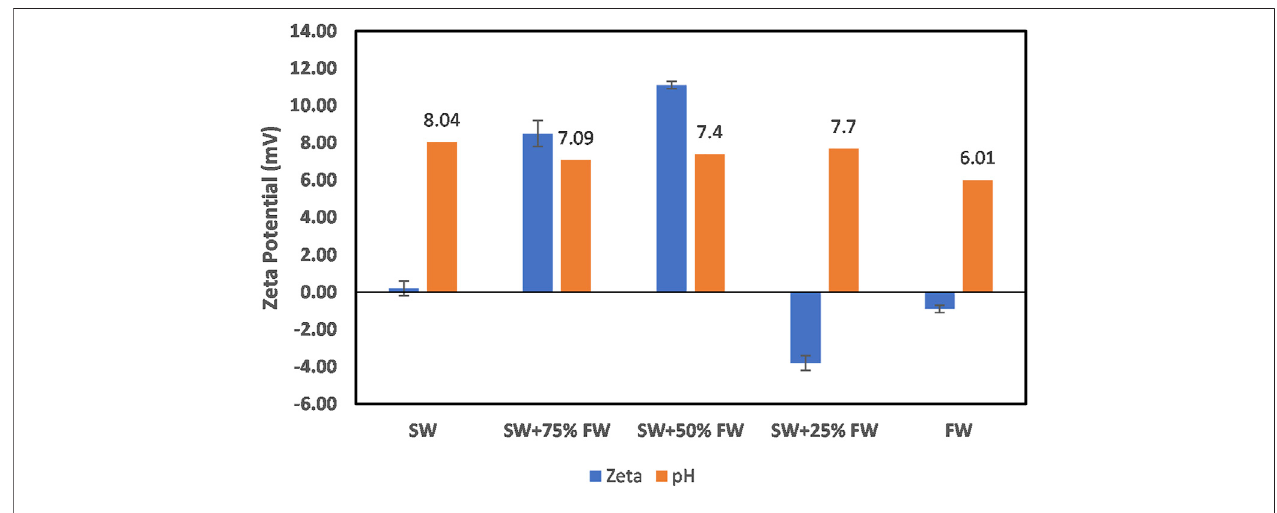
FIGURE 12 | Salinity gradient effect on the feldspar particle surface charge.